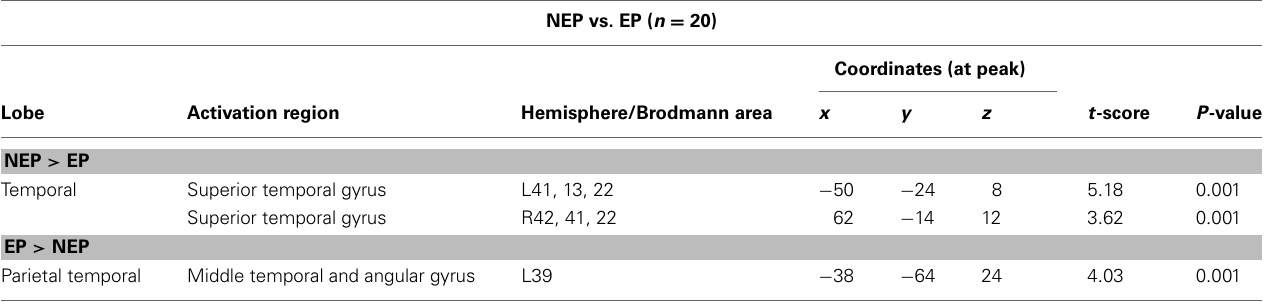
Table 2 | Univariate Across language comparisons.